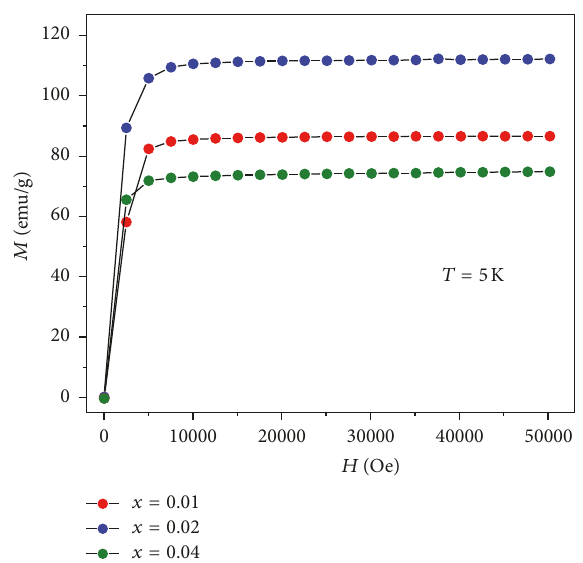
Figure 2: Field dependence of the magnetization 𝑀(𝐻) at 𝑇 = 5 K.